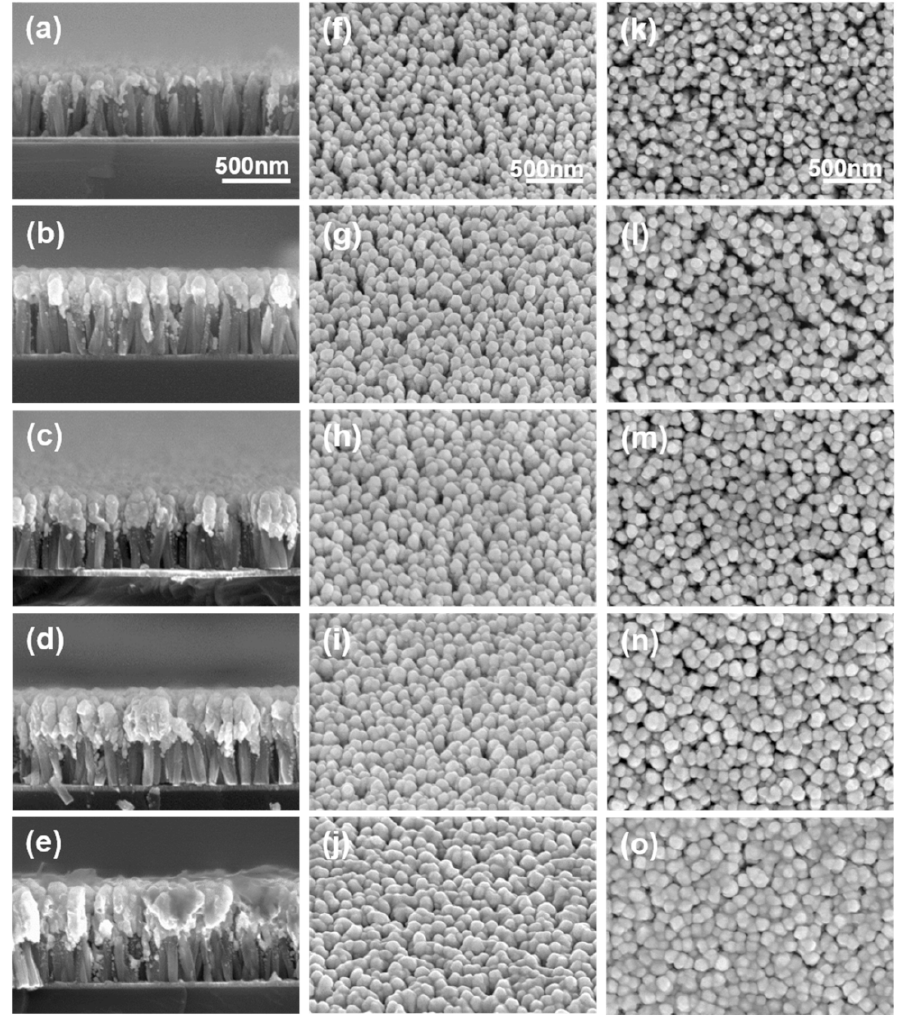
Figure 2. Secondary electron images of the ZnO nanorod substrates show morphology changes based on deposition of different equivalent thickness of gold: ( a , f , k ) Au: 100 nm; ( b , g , l ) Au: 150 nm; ( c , h , m ) Au: 200 nm; ( d , i , n ) Au: 250 nm; and ( e , j , o ) Au: 300 nm. ( a – e ) cross-sectional images show slight increases in thickness with increased gold deposition. ( f – j ) 45-degree tilted images, and ( k – o ) plane images show increased filling at higher Au